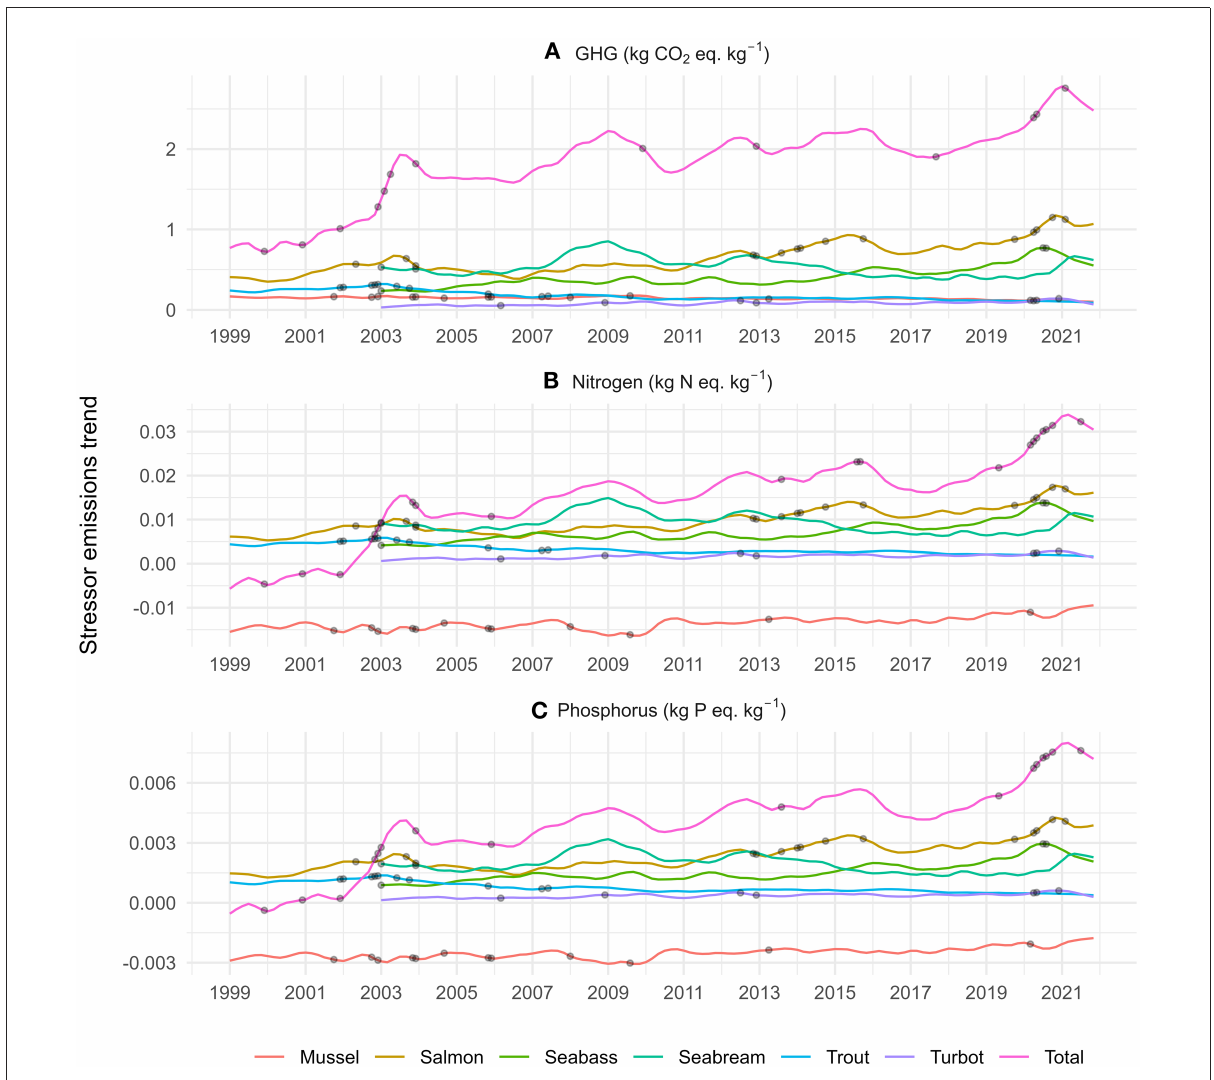
FIGURE6 Deseasonalised time series (1999–2021) of stressor emissions: (A) greenhouse gas (GHG), (B) nitrogen, and (C) phosphorus associated with monthly consumption (kg per capita) of farmed species. Black dots denote anomalies detected with generalized extreme studentised